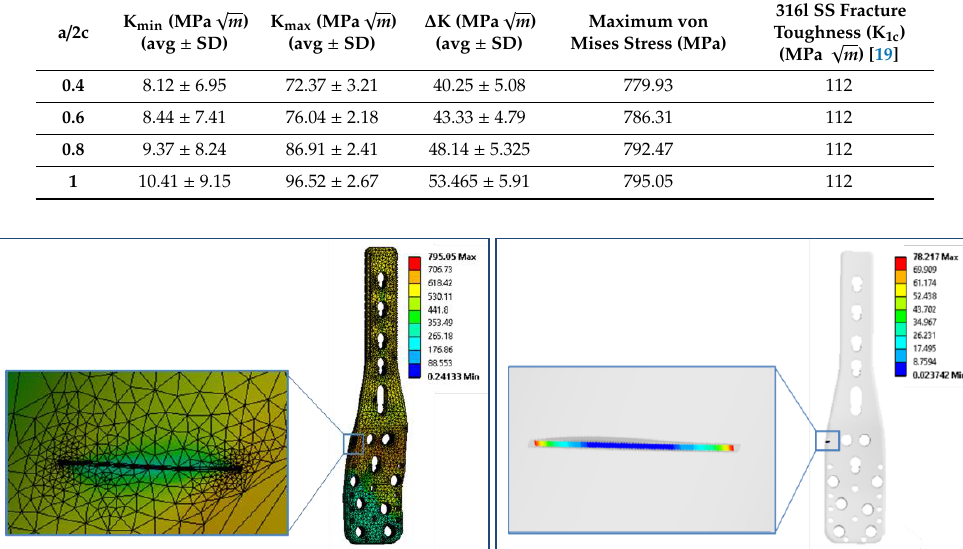
Figure 9. The von-Mises stresses in the 316L SS plate with screw design B, 2000 N axial load, 0.5 coefficient of friction between the screw and the plate, 0.1 mm cortical screw displacement, and 1 mm crack length ( left ). The stress intensity factor distribution across the crack for 0.6 aspect ratio ( right ).